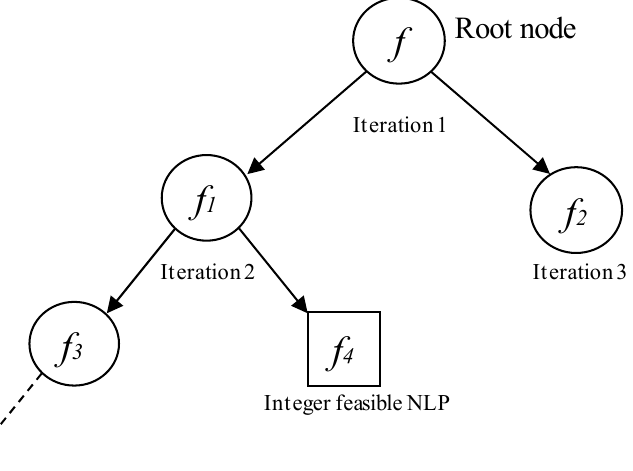
Figure 1. Branch and bound tree diagram [23] .